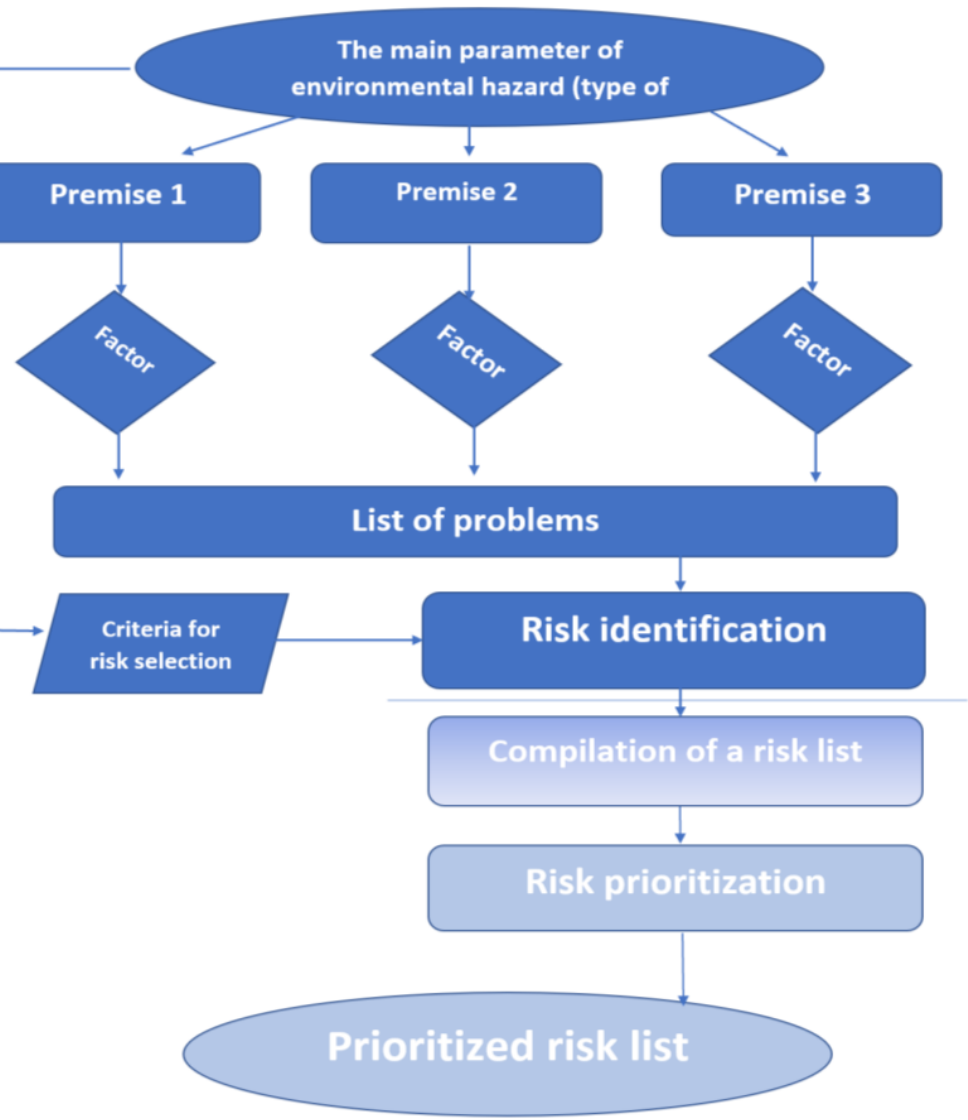
Figure 1. The logic of risk identification from the negative impact on the Arctic environment (the main parameter of environmental hazard —“ type of economic activity ” ). Compiled by the authors.